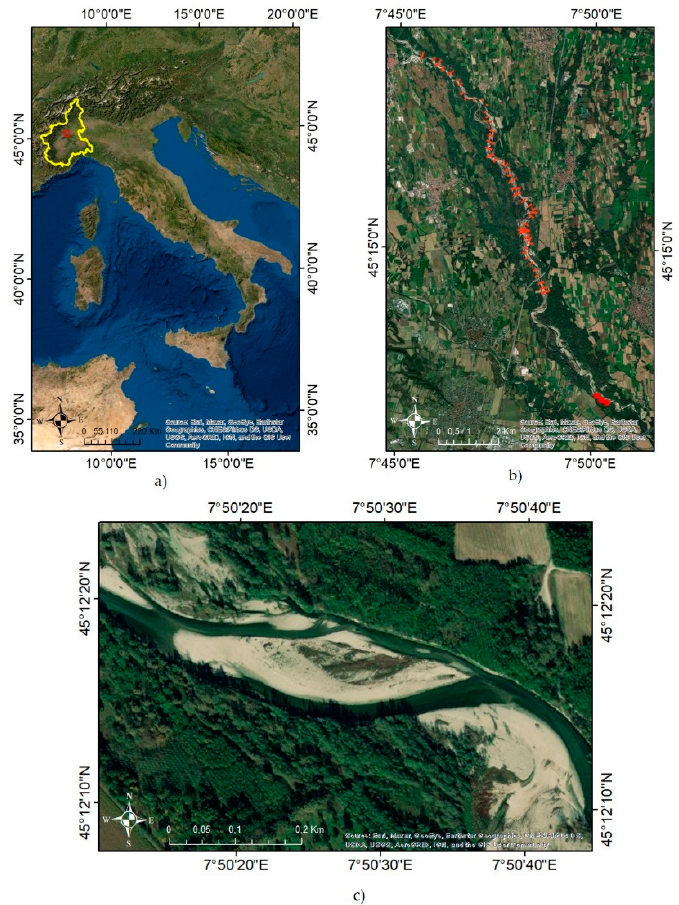
Figure 1. ( a ) Localization of Orco River in Northern Italy. ( b ) Reaches of the survey and cross-sections used in the refraction correction approach. ( c ) Zoom-in of a single reach. Captures from WMS-linked server in ArcMap software.